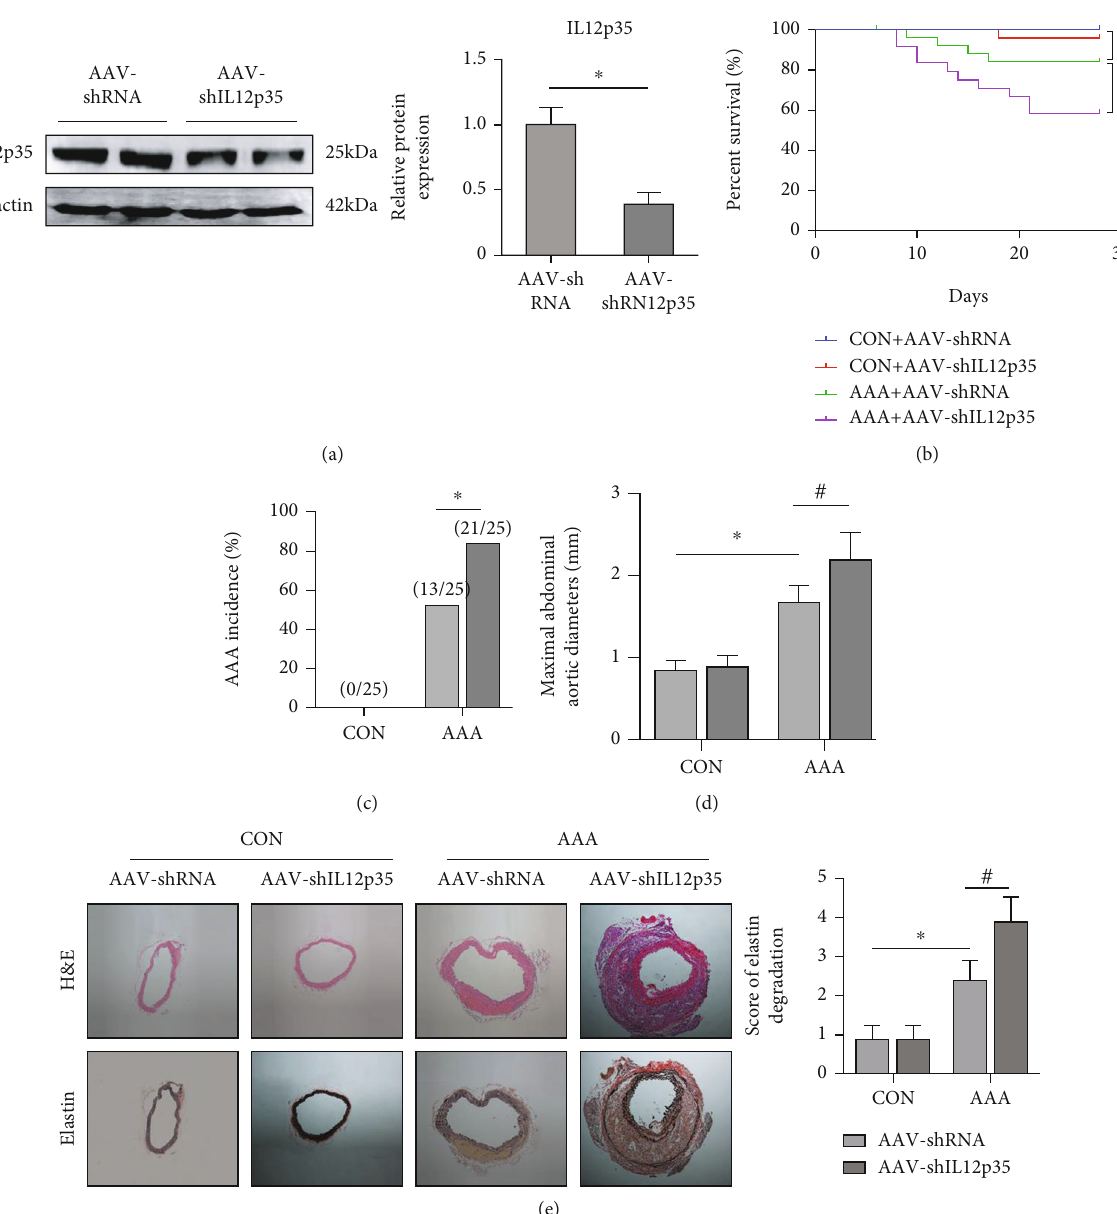
Figure 2: IL12p35 silencing promotes Ang II-induced AAA formation and rupture. (a) Western blot analysis of IL12p35 expression after AAV-shIL12p35 injection in mice ( n = 5 per group). (b) The survival curves of mice in the four groups ( n = 25 per group). (c) The rupture rates of mice in the four groups ( n = 25 per group). (d) Maximal abdominal aortic diameters of mice in the four groups ( n = 10 per group). (e) Representative H&E and elastin staining in the four groups of mice ( n = 8 per group). ∗ P < 0 : 05 compared with the control group; # P < 0 : 05 compared with the AAA